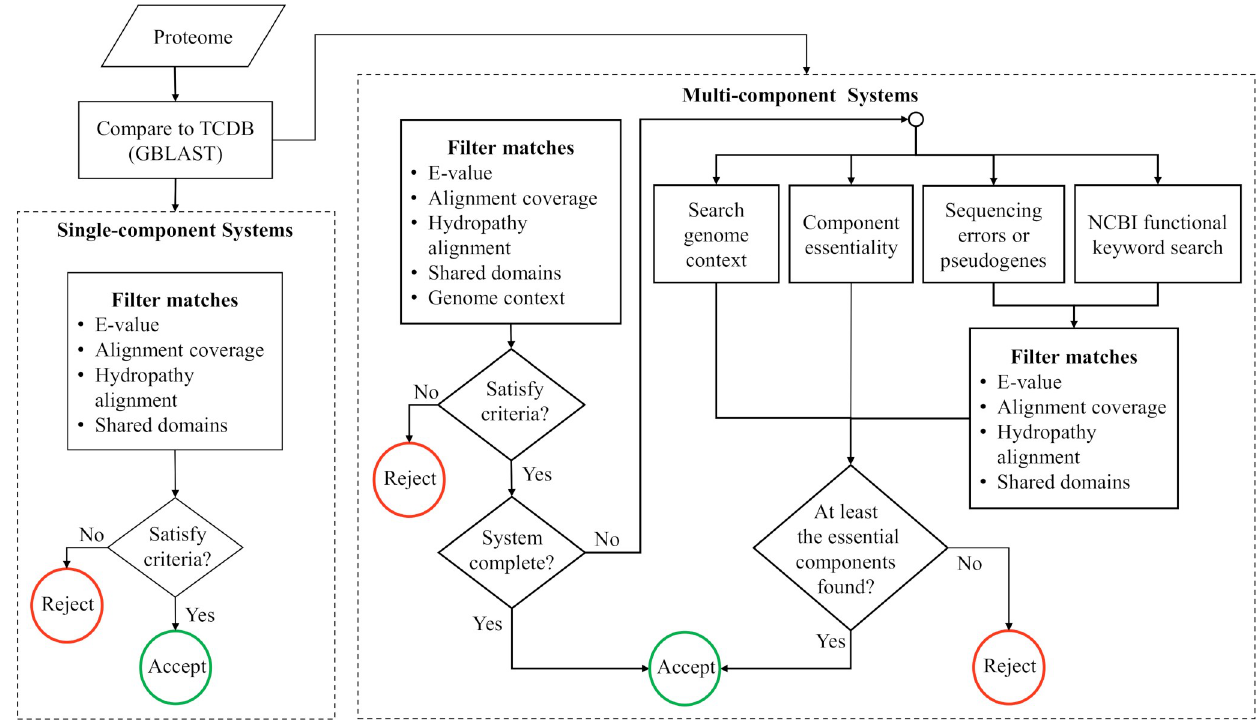
Fig 1. Strategy for characterizing transport systems. To characterize the five Asgard transportomes, candidate single- and multi-component systems were identified in each proteome following the multiple criteria shown in this flow chart. See methods for a detailed description.